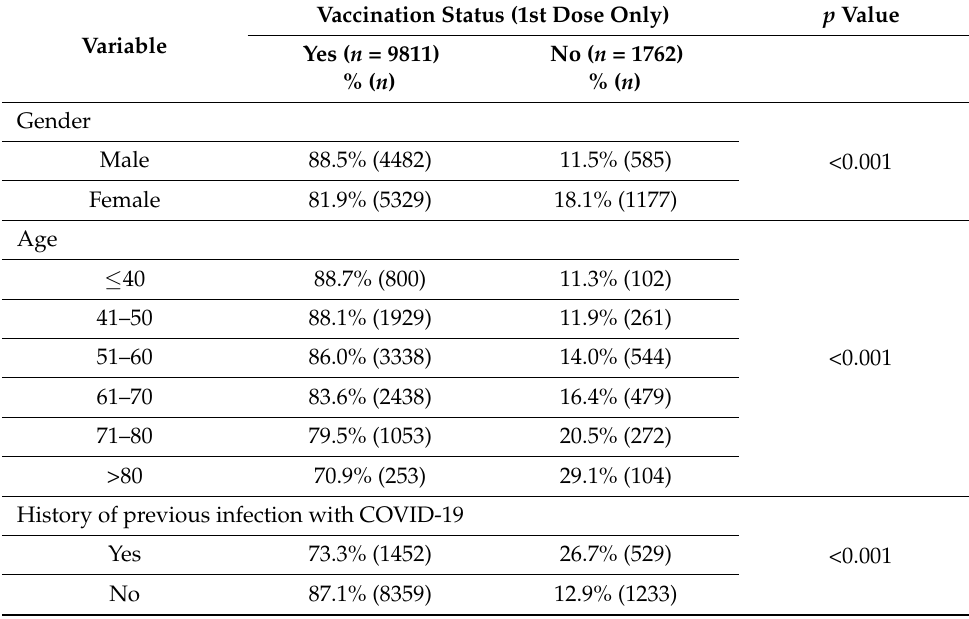
Table 3. Association between vaccination status and patient characteristics.